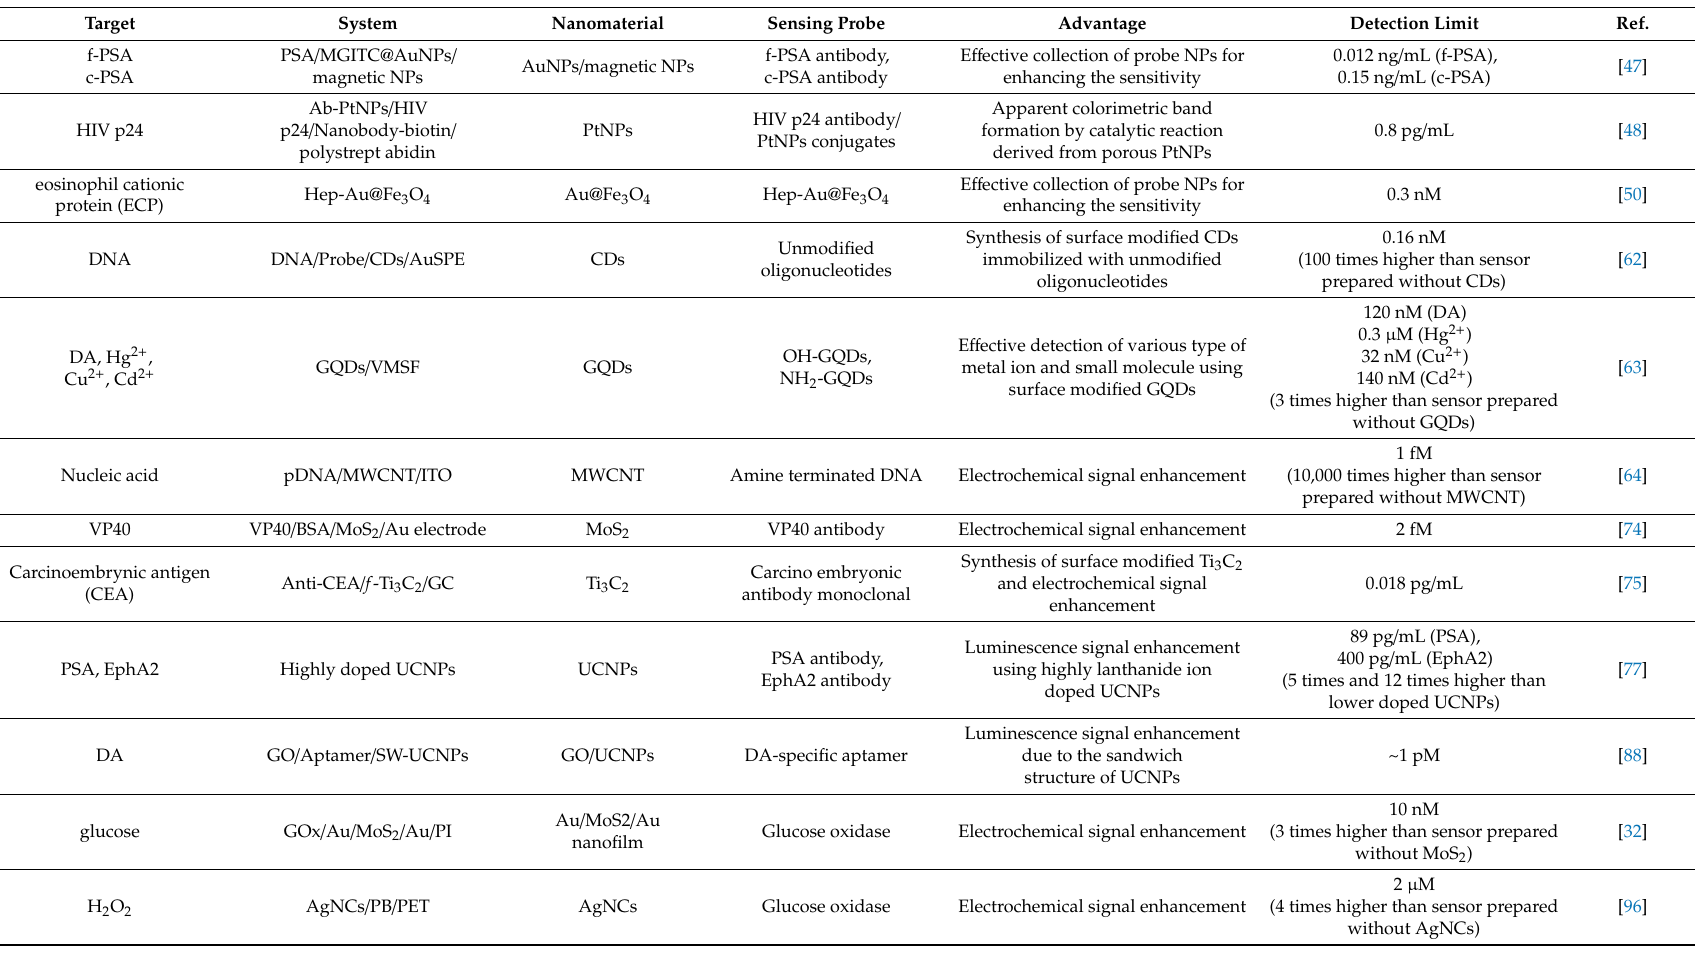
Table 1. Comparison and characteristics of nanomaterials utilized in highly sensitive